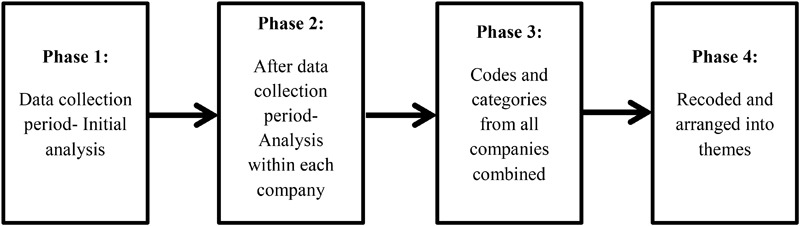
Phases of analysis.